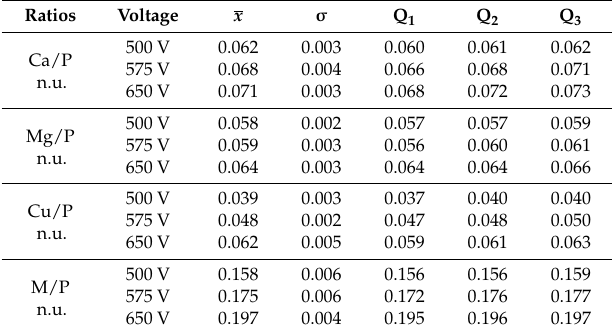
Figure 3. Atomic ratios (EDS) of coatings formed in Electrolyte 2. Table 5. Statistical description of EDS of coatings formed in Electrolyte 2. n.u., no units.